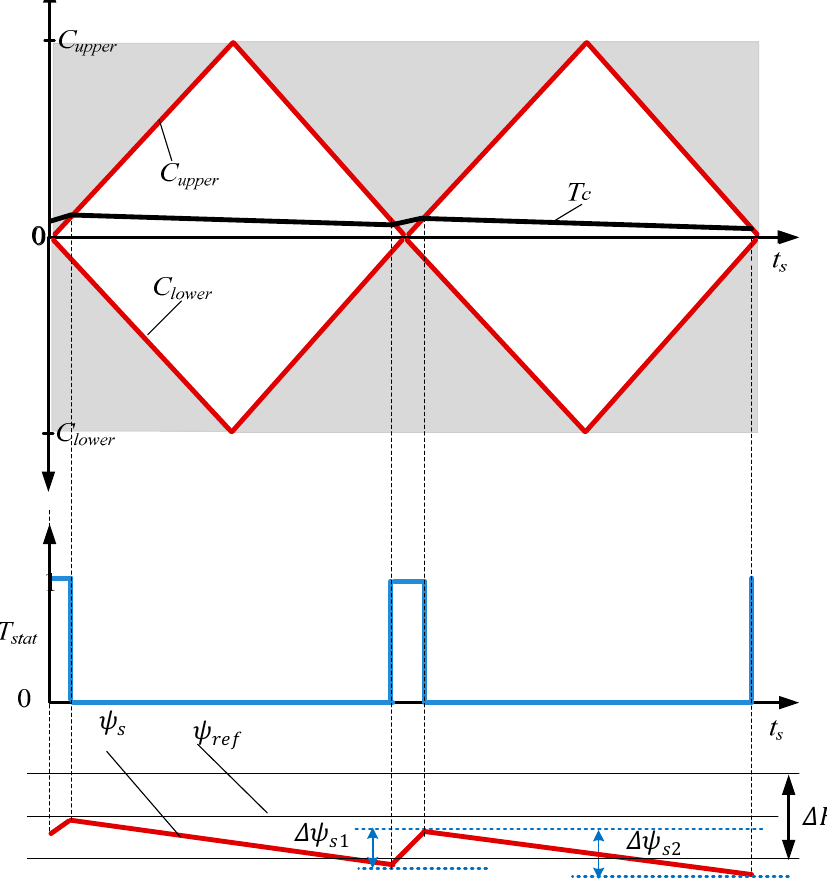
Figure 2. Conventional structure of CFTR-DTC.